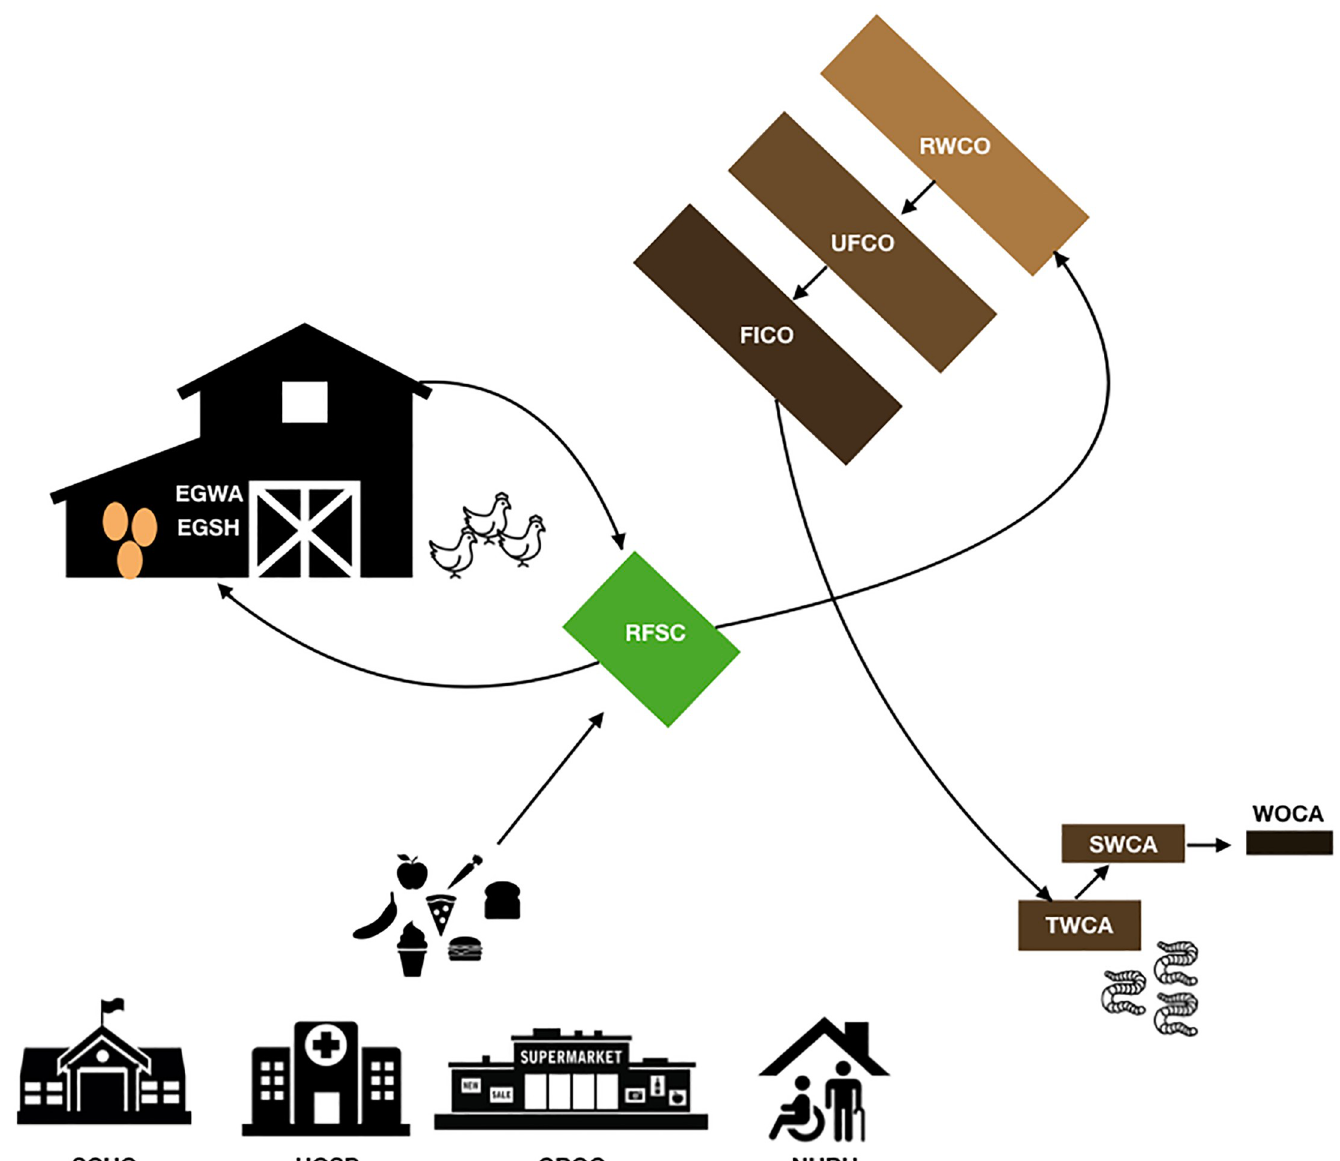
Fig 1. Map of sampling scheme and directionality of food waste movement on the